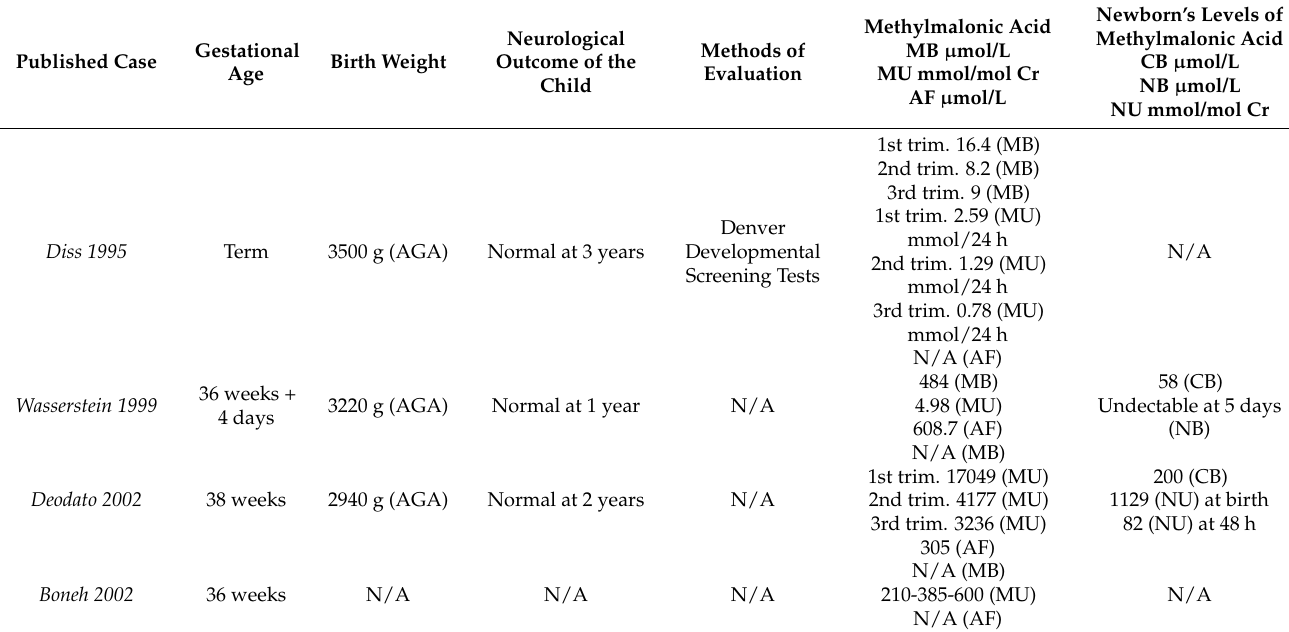
Table 2. Characteristics of the published children of methylmalonic acidemia